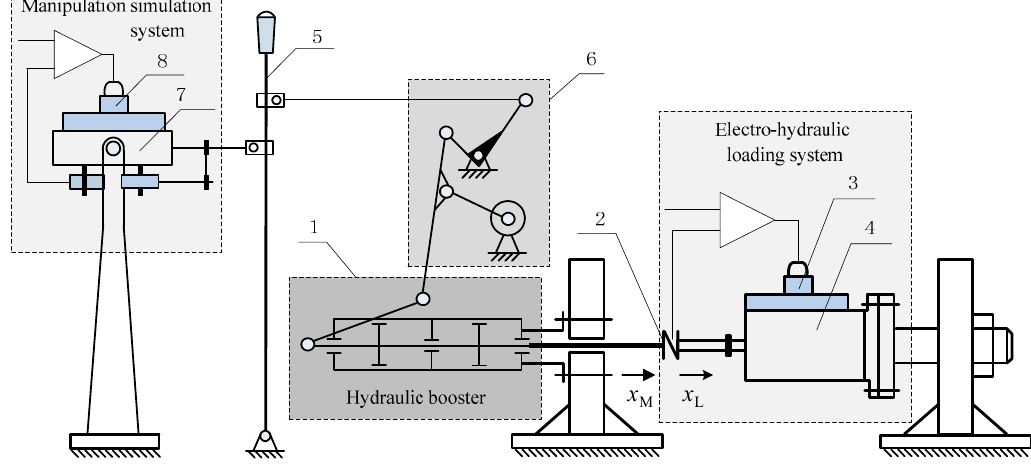
Figure 1. Schematic diagram of the electro ‐ hydraulic loading system. 1. Booster; 2. Force sensor; 3. Loading servo valve; 4. Loading cylinder; 5. Control rod; 6. Linkage mechanism; 7. Motion